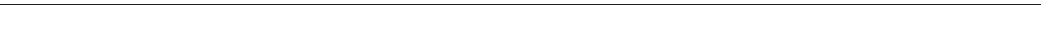
Fig. 5 H2A.Zac-promoter and enhancer remodeling of cancer-related genes. a University of California Santa Cruz (UCSC) genome browser hg19 screen shots of representative genes that exhibited remodeling of H2A.Zac at promoters and/or enhancers between PrEC and LNCaP. In these screen shots different types of data are presented for both PrEC and LNCaP cell lines (from top to bottom): ChromHMM color-coded according to the different states (see legend); merged tracks of H2A.Z (green) and H2A.Zac (red) ChIPseq signal (RPM); NOMe-seq tracks for chomatin accessibility (NOMe occupancy) in which 1-mGpC ratio (0 – 1) is represented as a gray bar in 100 bp smoothed resolution. NDRs were called from the NOMe-seq data (with a p- value cutoff of − log10(p) > 15) and are represented as black blocks (NOMe NDR); NOMe-seq tracks for DNA methylation (NOMe DNA methylation) in which mCpG ratio (0 – 1) is represented as a black bar in 100 bp smoothed resolution; Differences in DNA methylation ratio between LNCaP and PrEC (DNA methylation Δ LNCaP-PrEC) were calculated in each 100 bp bin, gray bars represent loss in LNCaP (negative value) and black bars represent gain in LNCaP (positive value). The dashed blue rectangles highlight the regions selected for the validation of the chromatin accessibility by targeted NOMe-seq (section b). All of the selected gene examples are androgen-regulated genes (based on expression array data and AR ChIP-seq) and are also up-regulated in LNCaP compared with PrEC as shown in Fig. S2A. b Targeted NOMe-seq validation of chromatin accessibility and its correlation with H2A.Zac presence. Upper panel, merged IGV tracks of PrEC (top) and LNCaP (bottom) cells showing H2A.Zac ChIP-seq signal (orange, 0 – 3 RPM) merged with targeted NOMe-seq data (dark blue bars blue bars, 0 – 1, represented as 0 – 1 ratio of each 1-mGpC site), of two enhancer regions, GREB1 and TRPM8 and one promoter region, KLK2. The bottom diagrams represent a magni fi cation at the identi fi ed NDR of each genomic region were the x axis represents each GpC site and the y axis is the average ratio of 1-mGpC of each site, in PrEC (green) and LNCaP (red). The regions analyzed by targeted NOMeseq were CpG poor disabling us